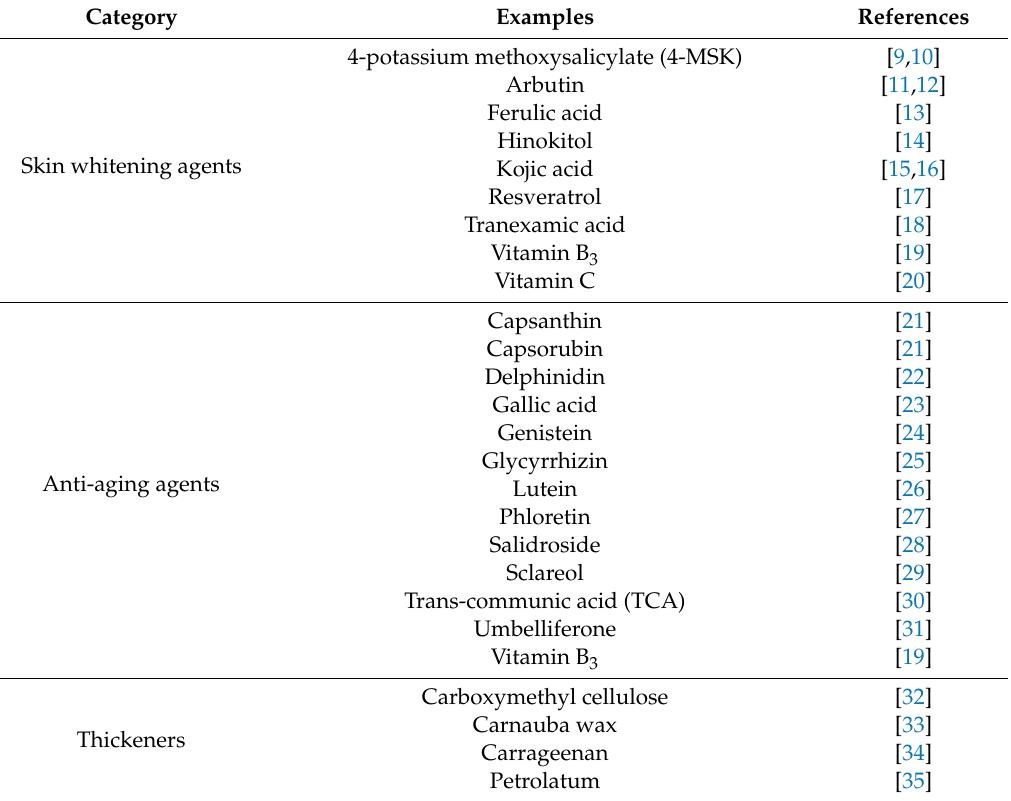
Table 1. Halal cosmetic